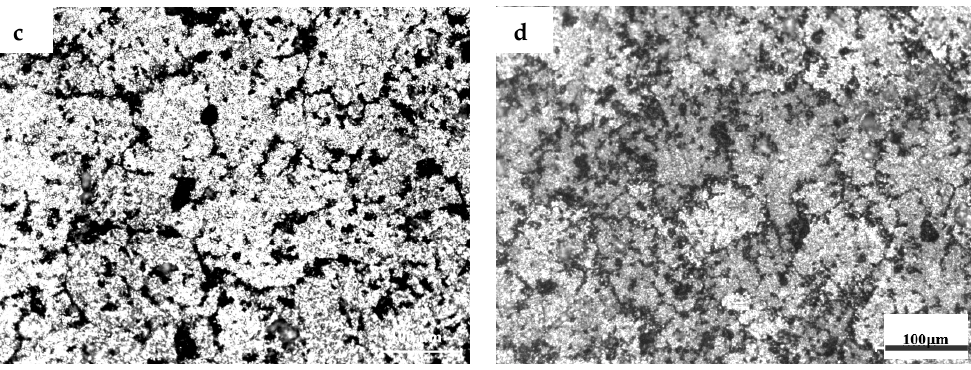
Figure 1. The microstructures of TiB 2 /7075 Al matrix composites. ( a ) 3.0% TiB 2 /7075; ( b ) 4.5% TiB 2 /7075; ( c ) 6.0% TiB 2 /7075; ( d ) 9.0% TiB 2 /7075.